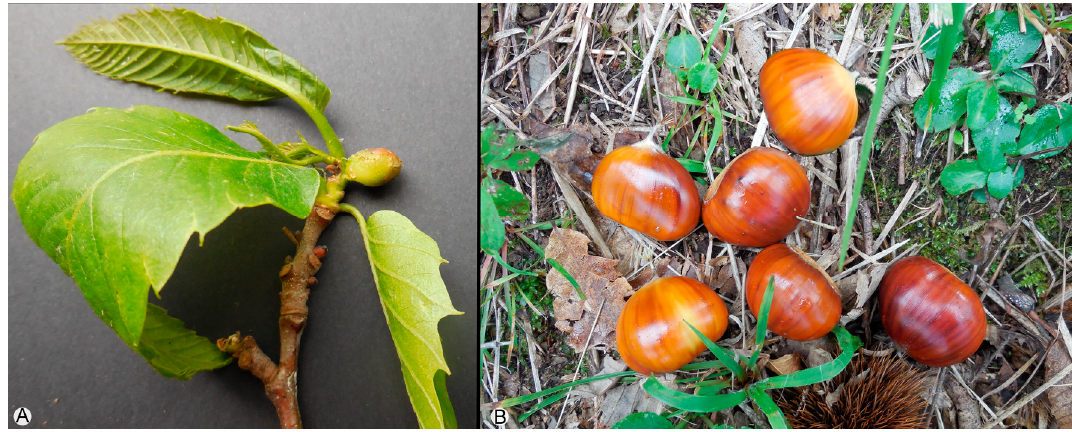
Figure 7. Shoot with gall and leaves collected on red salernitan ecotype (RSE) tree ( A ); RSE chestnut fruit ( B ).